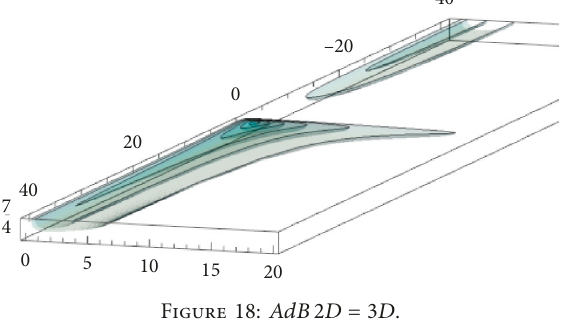
Figure 18: AdB 2 D � 3 D